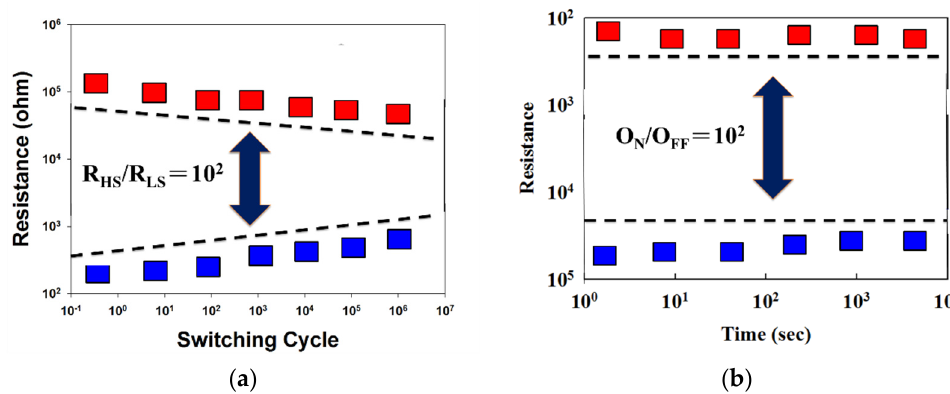
Figure 11. Switching endurance of the transparent ITO/ITO X /ITO RRAM for ( a ) retention properties, and ( b ) endurance properties (measured at room temperature).